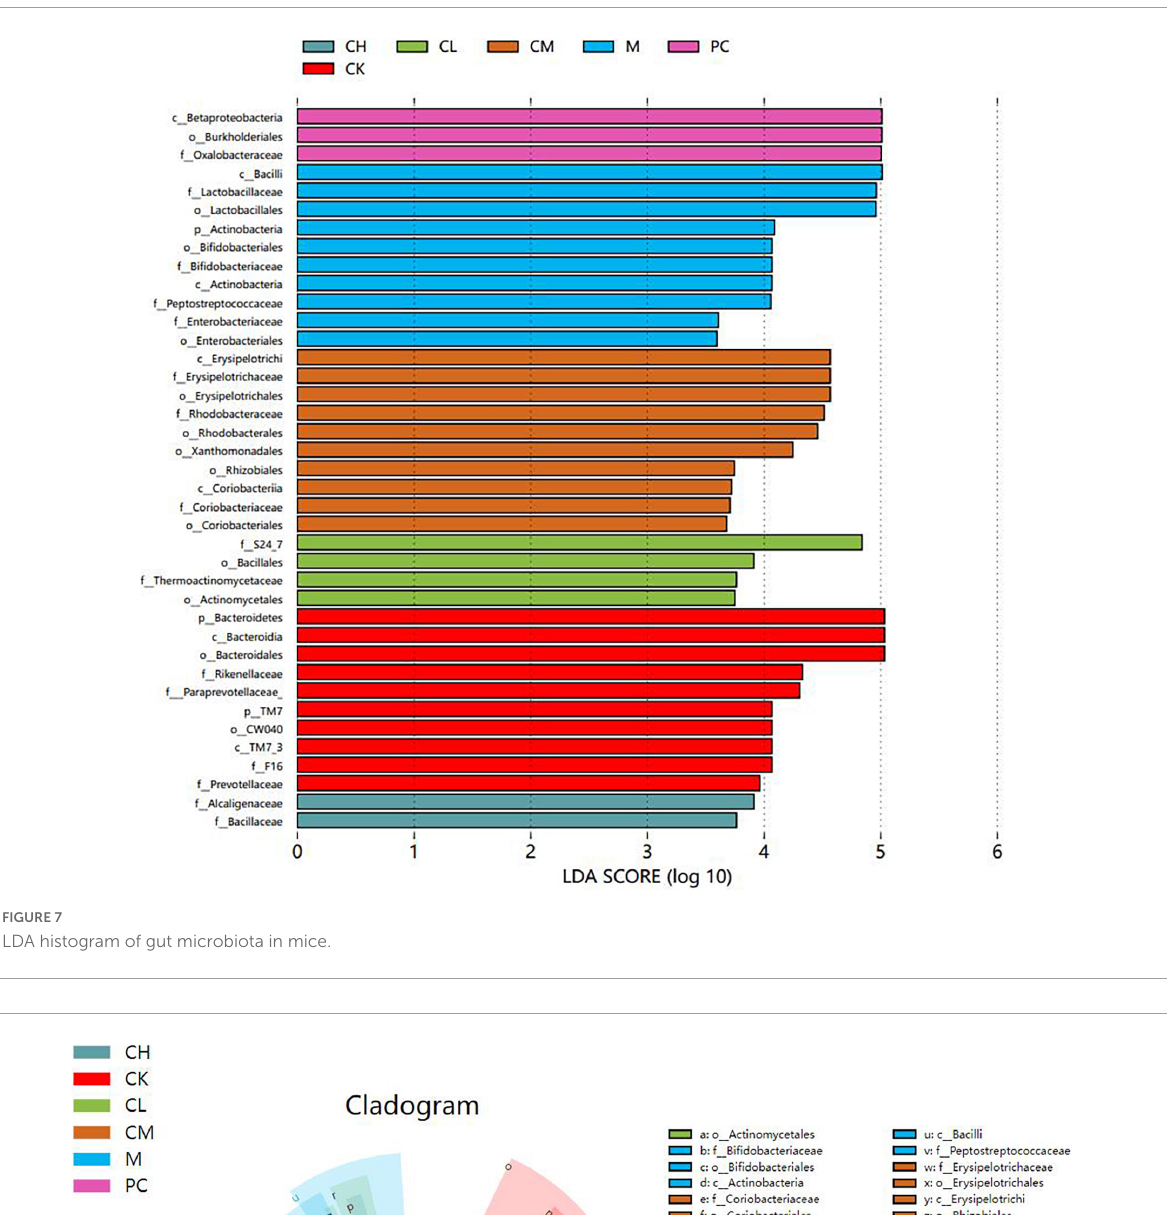
FIGURE7 LDA histogram of gut microbiota in mice.